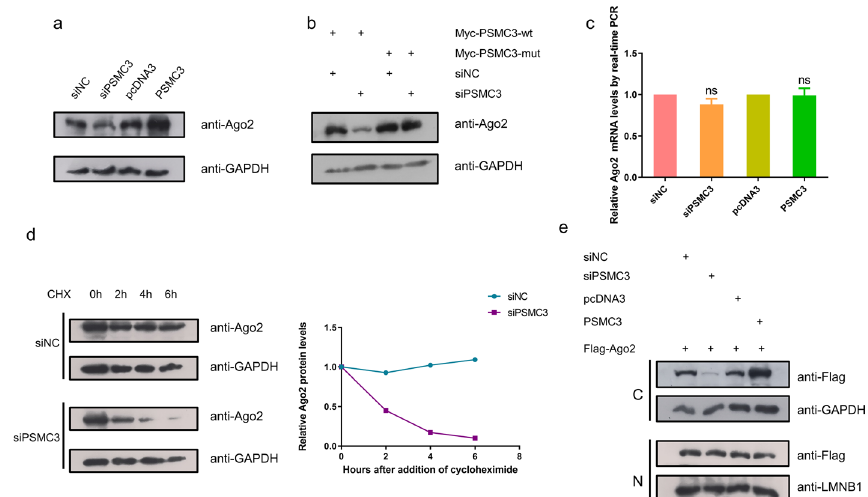
Fig. 4 PSMC3 is essential to maintain AGO2 protein levels. a PSMC3 increases AGO2 protein levels. HeLa cells were transfected with the indicated plasmids. Extracts were collected at 48 h post-transfection and subjected to western blotting analysis with anti-AGO2 and anti-GAPDH antibodies. b Expression of siRNA-resistant PSMC3 abrogates the suppression of AGO2 caused by PSMC3-specific depletion. HeLa cells were co-transfected with plasmids encoding either the wild-type (wt) or mutant (mut) PSMC3 along with siPSMC3 or control siRNA. After 48 h, lysates were analyzed by western blotting with anti-AGO2 and anti-GAPDH antibodies. c Real-time RT-PCR analysis of endogenous AGO2 mRNA was performed using total RNA isolated from HeLa cells after 48 h of transfection with the indicated plasmids. GAPDH mRNAs served as the control. In all statistical comparisons, three independent experiments were performed (mean n 3, Student’s t -test). d Depletion of PSMC3 increases AGO2 protein turnover. HeLa cells were transfected = with control or PSMC3 siRNA. After 48 h, the cells were treated with 100 µg/mL of cycloheximide (CHX) for the indicated periods and then harvested for immunoblotting with anti-AGO2 and anti-GAPDH antibodies (left). The results were plotted after quantitation (right). e Depletion of PSMC3 decreases the amount of AGO2 in the cytoplasm. HeLa cells were co-transfected with the indicated plasmids. Then nucleoplasmic or cytoplasmic extracts were harvested and analyzed by western blotting assays with anti-Flag, anti-GAPDH (cytoplasmic marker), and anti-LMNB1 (nucleoplasmic marker) antibodies. All results are representative of three independent